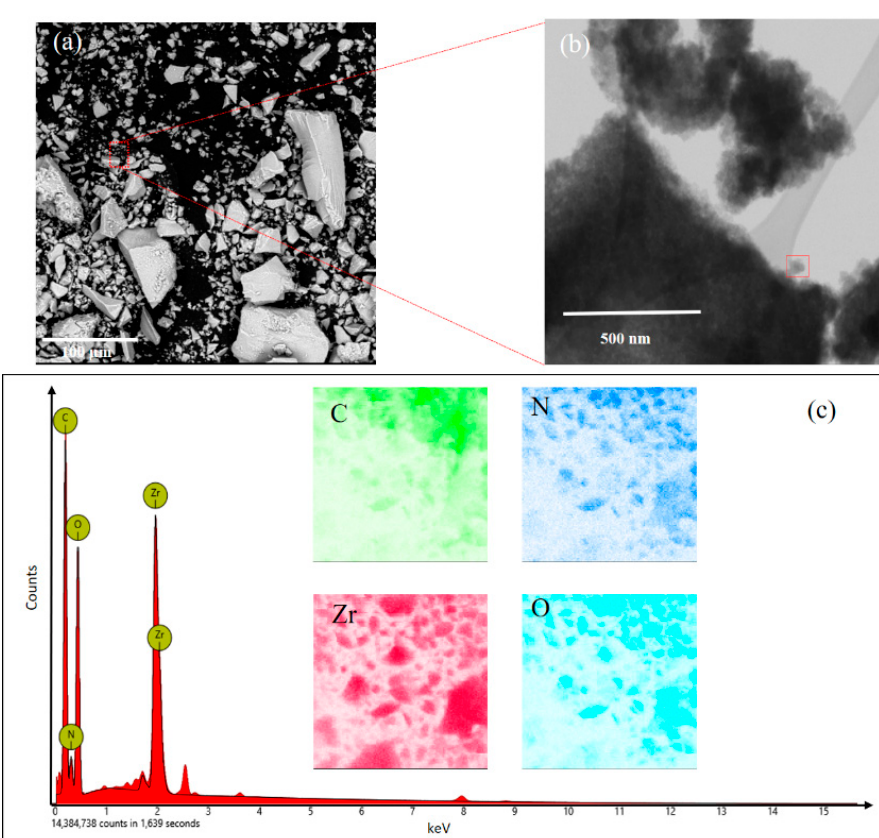
Figure 2. SEM (scanning electron microscope) images of synthesized UiO-66-NH 2 particles ( a , b ). ( c ) is the corresponding EDX (energy-dispersive X-ray spectroscopy) data and mapping results of the selected area in ( a ) of UiO-66-NH 2 particles.